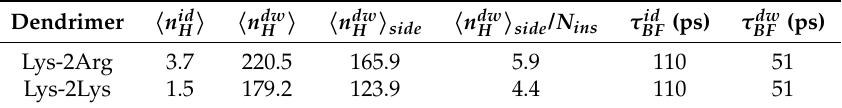
Table 5. The hydrogen bond characteristics of Lys-2Arg and Lys-2Lys: the average number of the (cid:105) and the dendrimer-water HB (cid:104) n dw inter-dendrimer HB (cid:104) n id H (cid:105) (cid:104) n dw (cid:105) water (cid:104) n dw side (per side segment side / N ins ); the lifetime of the intra-dendrimer HB τ H H dendrimer-water HB τ dw at T = 310 K. BF